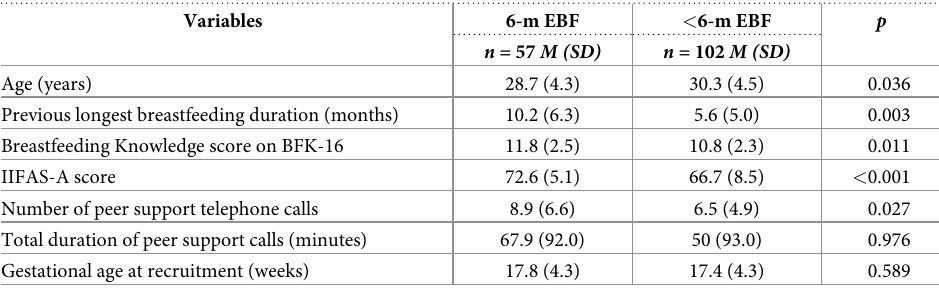
Table 1. Characteristics of the cohort ( N = 159).